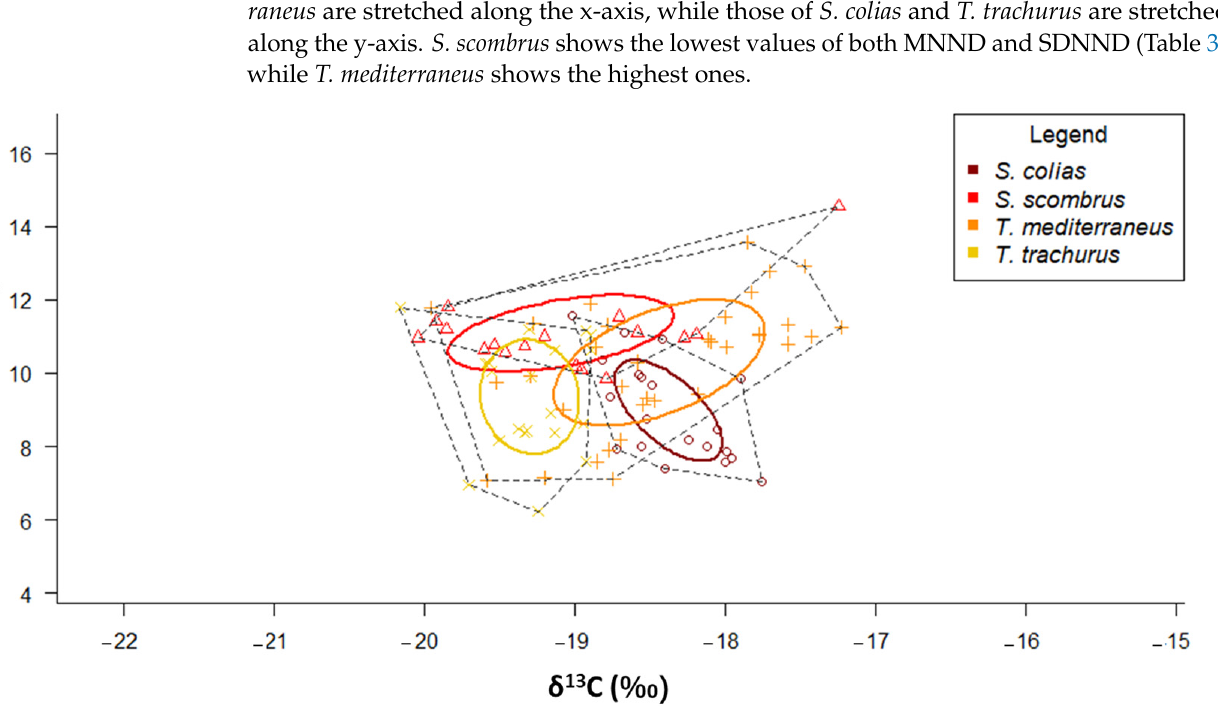
Table 3. Values of Total Area of the convex hull (TA) and of the corrected Standard Ellipse Area (SEA C ) obtained considering the four different “ancillary” species and the areas in which they were caught. Values of TA and SEA C are expressed as ‰ 2 . Other values are shown in the table: mean distance to centroid (CD), δ 15 N range (NR), δ 13 C range (CR), mean nearest neighbor distance (MNND) and standard deviation of the nearest neighbor distance (SDNND) SPECIES